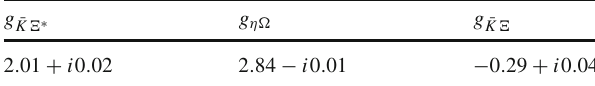
Table 2 Couplings of the (cid:2) ∗ to the three channels g ¯ K (cid:3) ∗